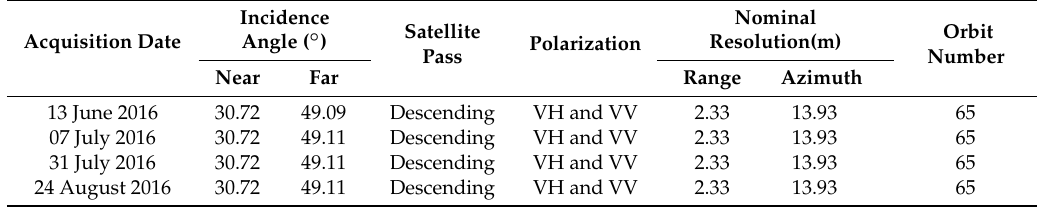
Table 2. Specifications of acquired Sentinel-1 datasets over Konya basin,